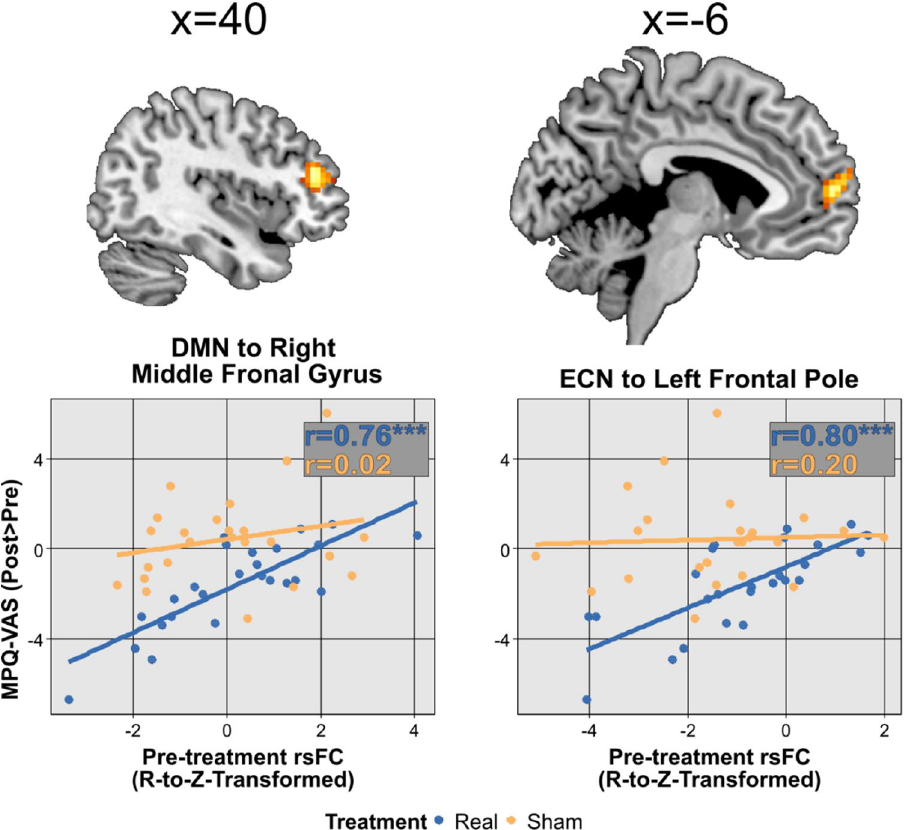
Figure 2. MPQ-VAS reduction following the real, but not sham M1-rTMS, was predicted by stronger resting- state FC of the DMN and ECN with the frontal pole. Coordinates in upper panels are in MNI space. r Pearson’s correlation coefficient; ***p < 0.001.